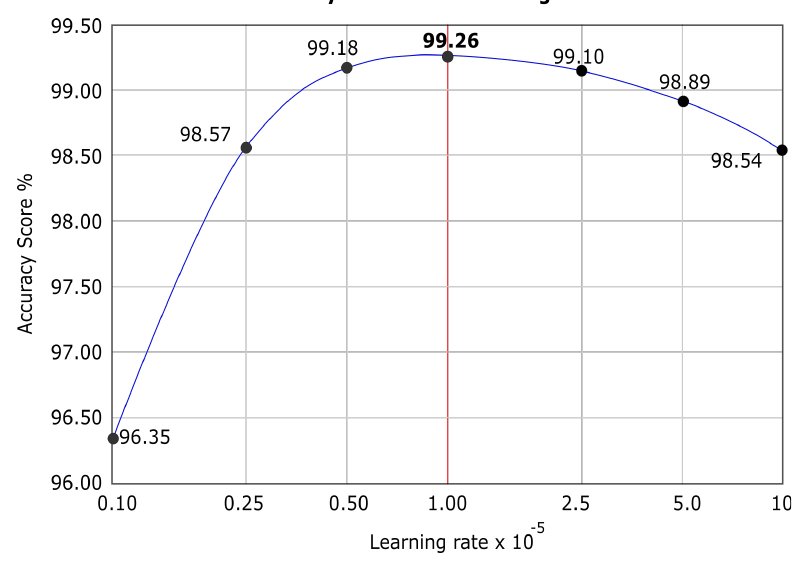
Figure 6. Accuracy obtained using different learning